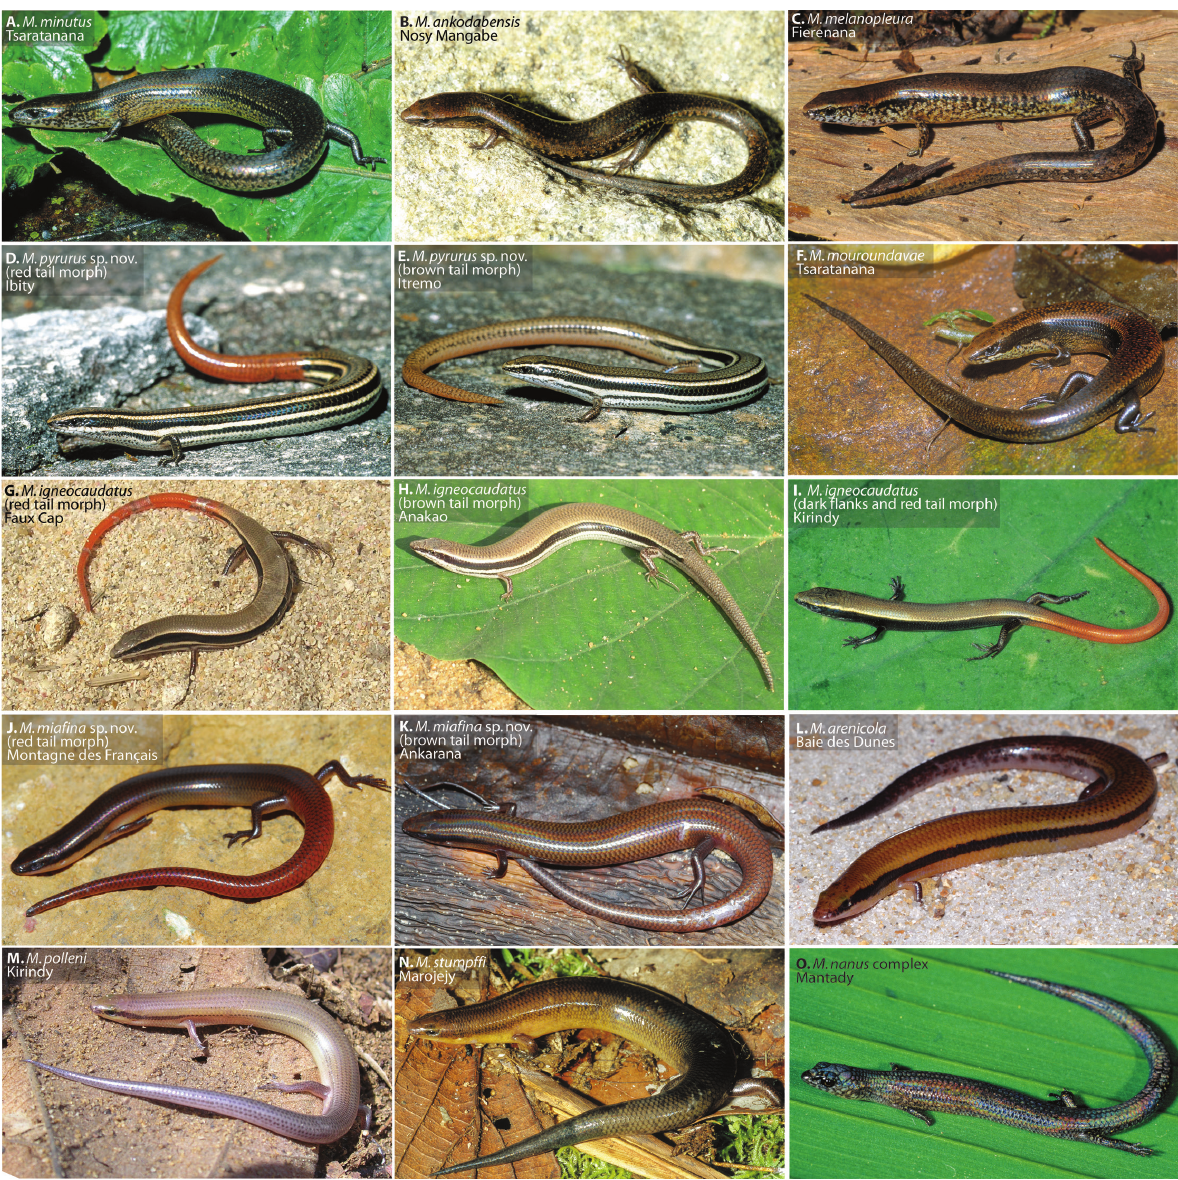
Figure 4. Photographic plate showing most of the recognized species of Madascincus (picture not available for M. macrolepis ), highlighting the chromatic polymorphism (red tail and brown tail morphs) for M. miafina sp. n., M. pyrurus sp. n. and M. igneocau- datus. Picture I depicts the sole specimen known from Kirindy that in Glaw and Vences (2007) was assigned to a candidate species M. sp. “vitreus”, and O depicts a specimen that these authors assigned to a candidate species M. sp.